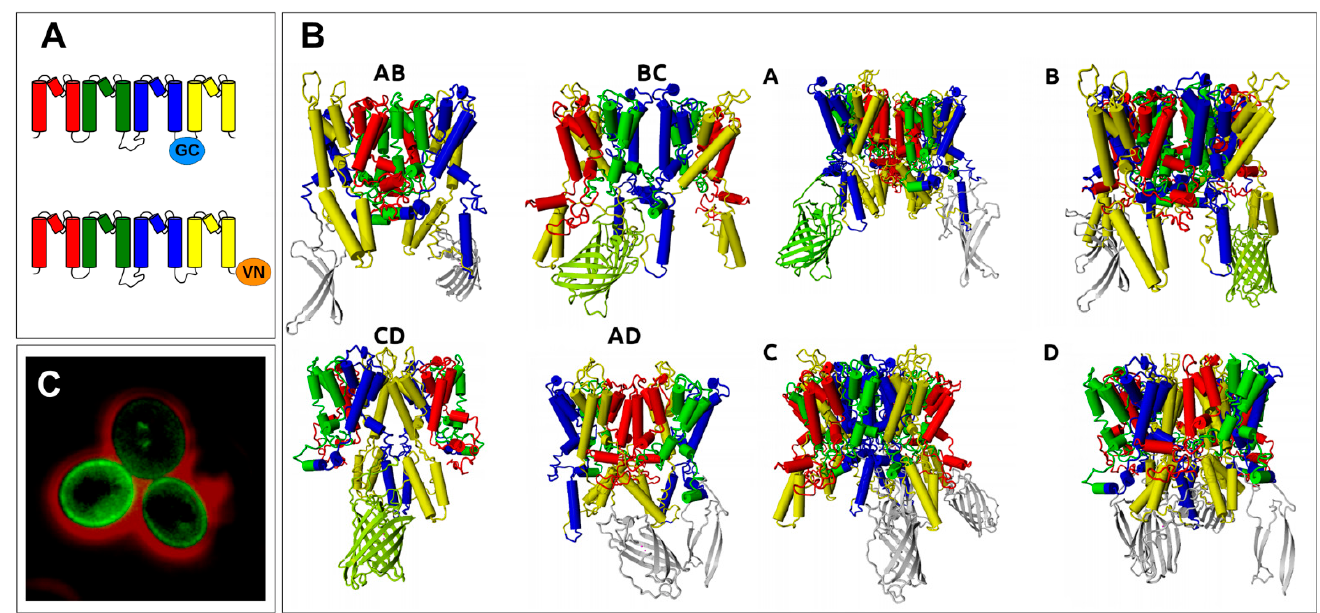
Figure 5. BiFC with GC inserted in loop three and VN attached to the C-terminus of Trk1[ Δ LHL]. ( A ) Schematic representation of Trk1[ Δ LHL] monomers with the C-terminal fragment of GFP (GC) inserted into intracellular loop three (Trk1[ Δ LHL][G1010/GC/E1011], top) and VN fused to the C- terminus (Trk1[ Δ LHL]/VN, bottom). ( B ) Models of symmetric dimers and tetramers indicating whether BiFC would be possible in the respective arrangement. ( C ) Fluorescence microscopy picture of (Trk1[ Δ LHL][G1010/GC/E1011] plus Trk1[ Δ LHL]/VN)